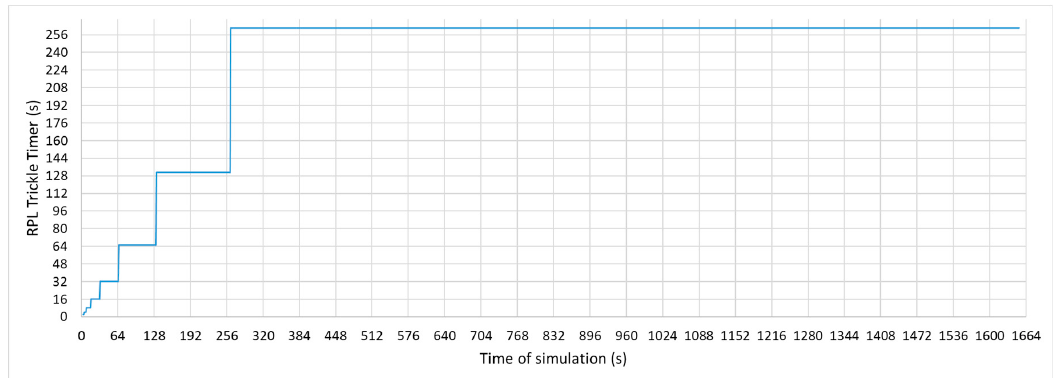
Sensors 2019 , x , x FOR PEER REVIEW Figure 3. Routing Protocol for Low-Power and Lossy Networks (RPL) Trickle Timer evolution over time.